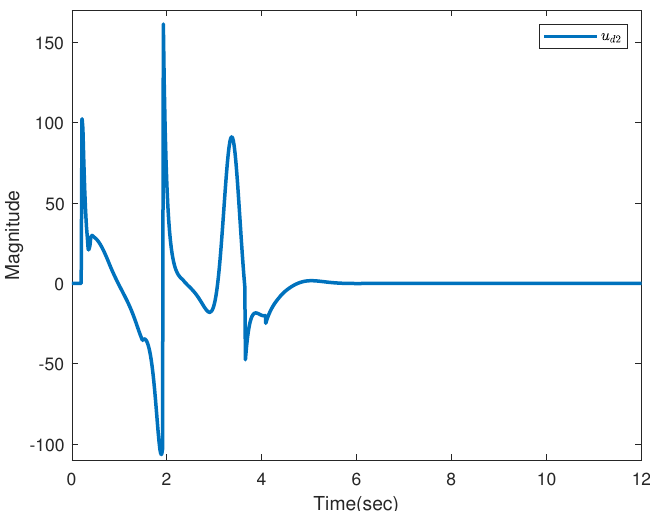
Figure 4. Convergence of the states of the system (15) and the estimates produced by the observer (16) to the origin.